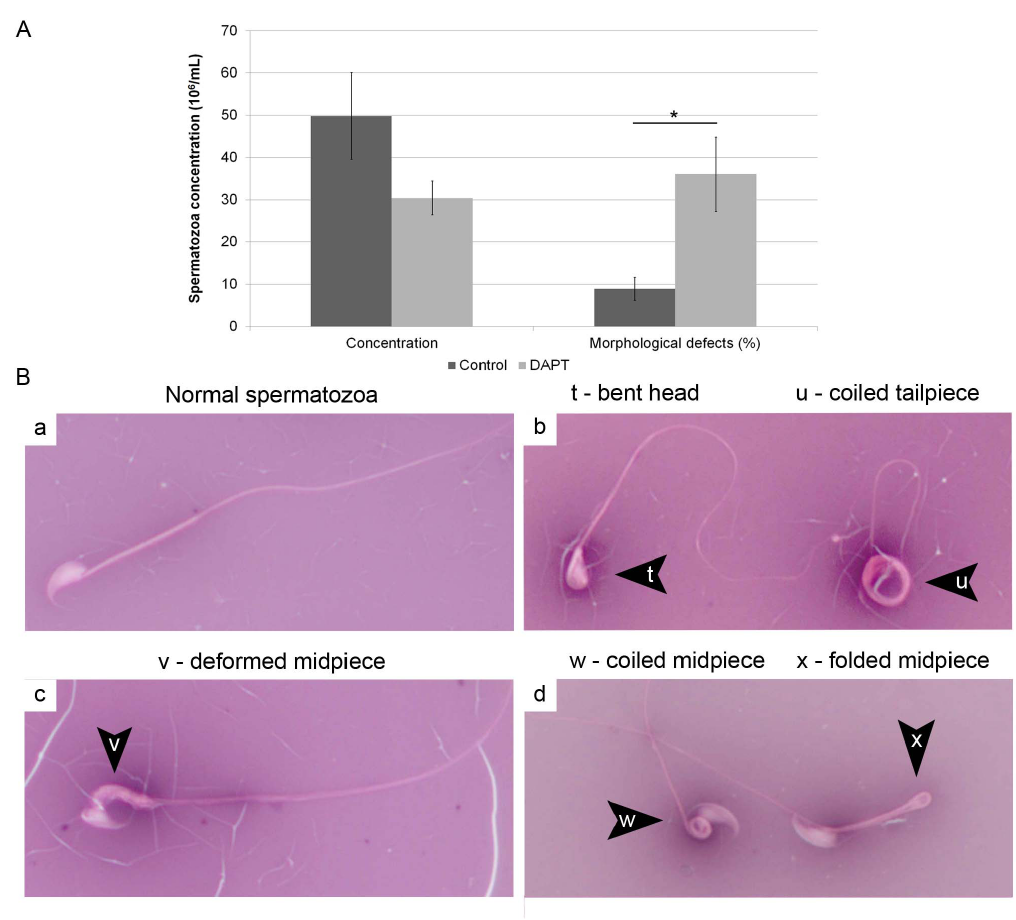
Figure 8. DAPT treatment significantly increases epididymis spermatozoa morphologic defects. A – Epididymis tail spermatozoa concentration (number of spermatozoa per mL of collection medium) and morphology evaluation. ( * ) p , 0.05 B – Main spermatozoa morphologic defects found in DAPT treated mice, eosin-nigrosin stain (400x magnification). Normal spermatozoa (a), morphological defects (b–d).